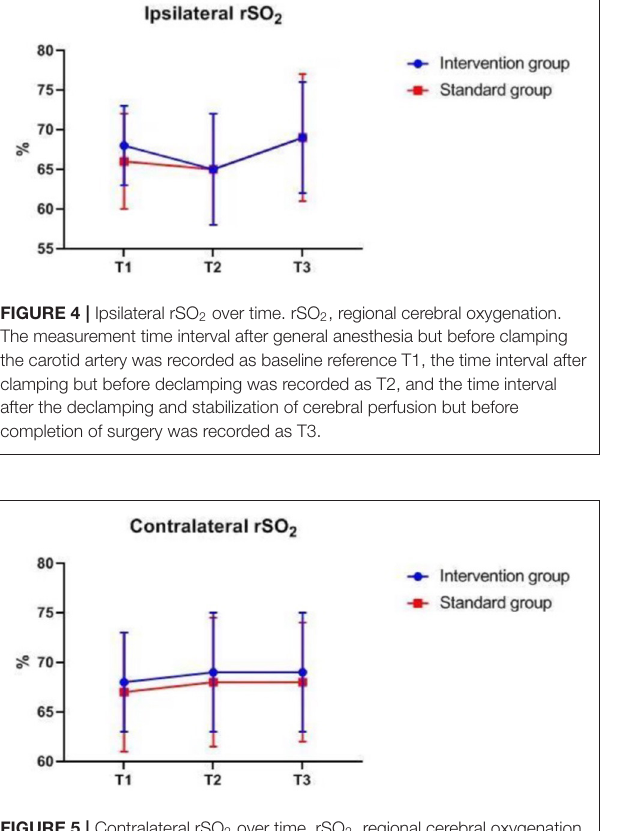
FIGURE 3 | P ET CO 2 over time. P ET CO 2 , end-expiratory carbon dioxide partial pressure. The measurement time interval after general anesthesia but before clamping the carotid artery was recorded as baseline reference T1, the time interval after clamping but before declamping was recorded as T2, and the time interval after the declamping and stabilization of cerebral perfusion but before completion of surgery was recorded as T3.